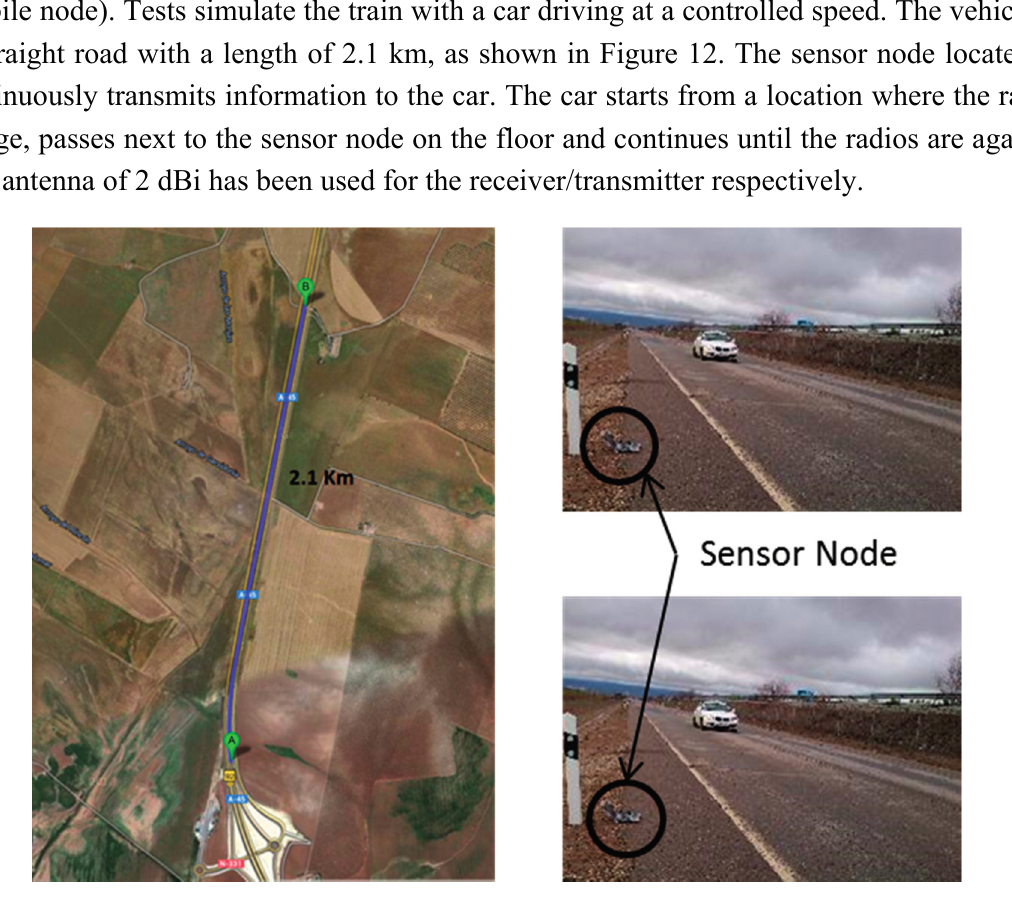
Figure 12. Evaluation scenario for the range